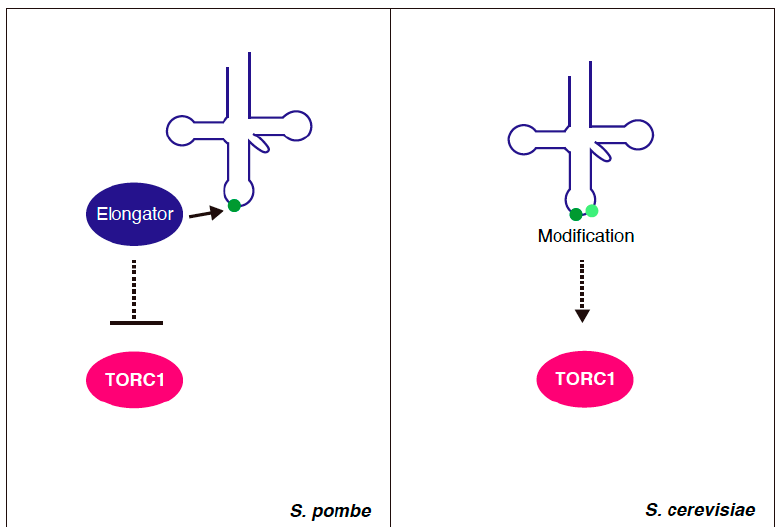
Figure 3. tRNA modification and TORC1. In Schizosaccharomyces pombe , Elongator, which catalyzes modification of the wobble base, negatively regulates TORC1. In Saccharomyces cerevisiae , tRNA modification acts positively on TORC1. Table 2. tRNA-related S. pombe genes upregulated more than three-fold after treatment with rapamycin and ca ff eine.